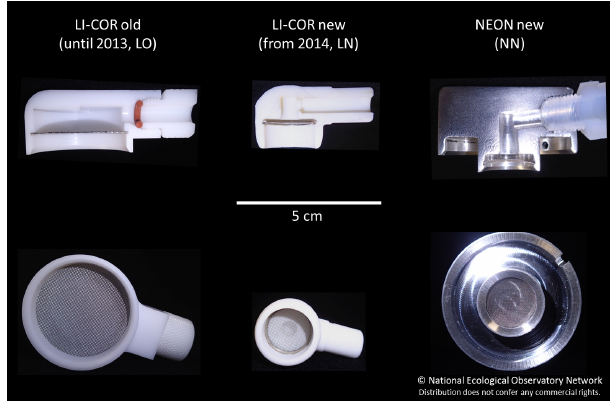
Figure 1. Three selected rain cap designs tested in this study. Top row: cross sections of each rain cap showing their internal volumes. Bottom row: rain cap inlets with screens that face downwards in typical field